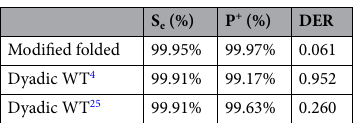
Table 6. Performance of ECG detectors on 1-h